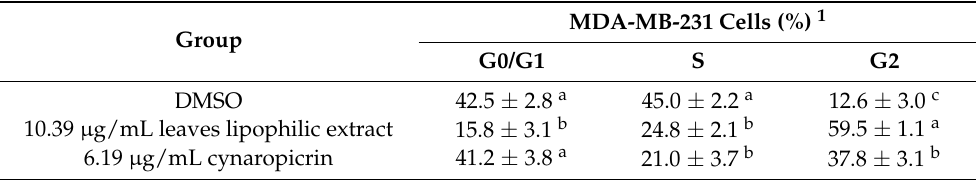
Table 2. Cell cycle phases distribution of MDA-MB-231 cells, after 48 h treatments with cultivated cardoon leaves lipophilic extract (10.39 µg/mL) and cynaropicrin (6.19 µg/mL). Solvent control cells received DMSO (0.09% ( v / v )).